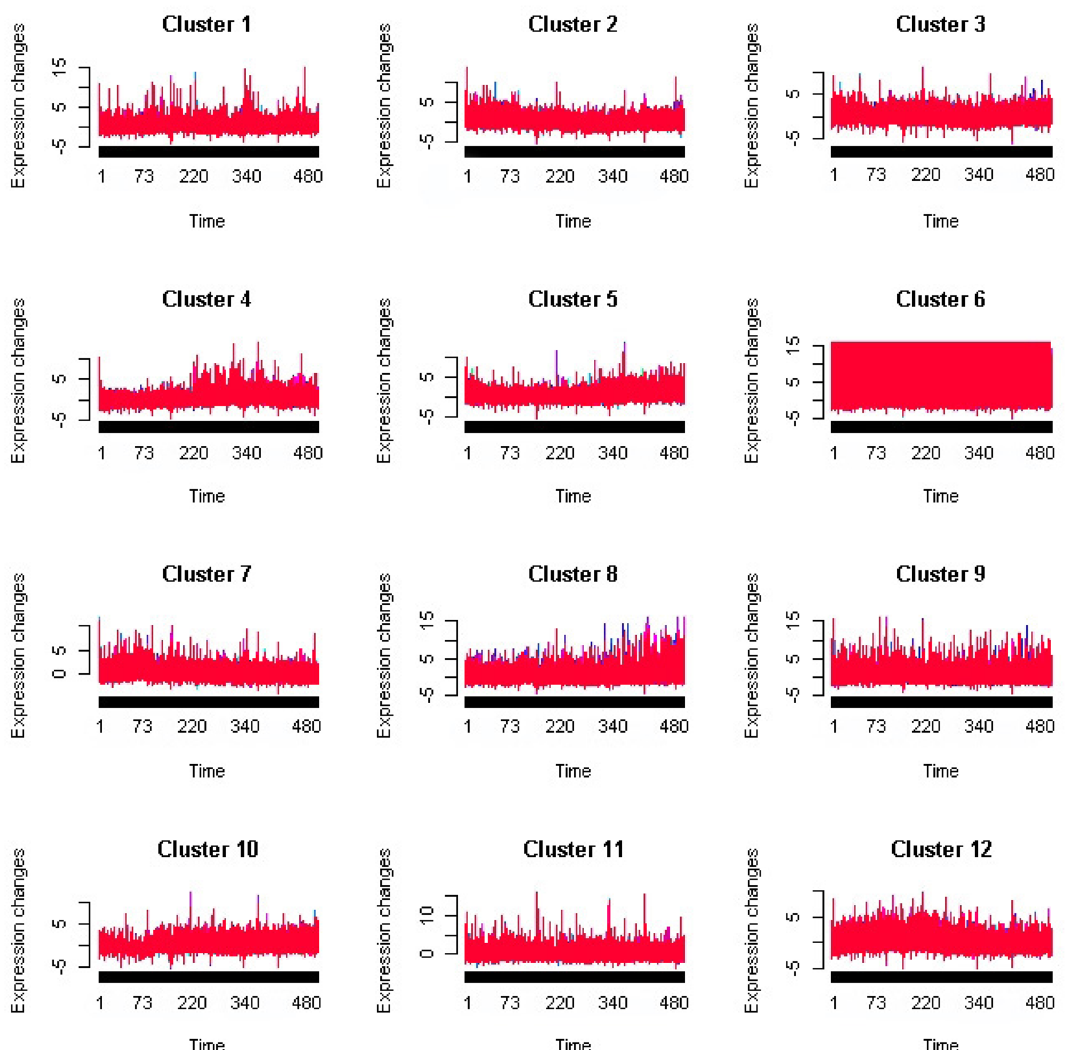
Figure 10. The results of cluster